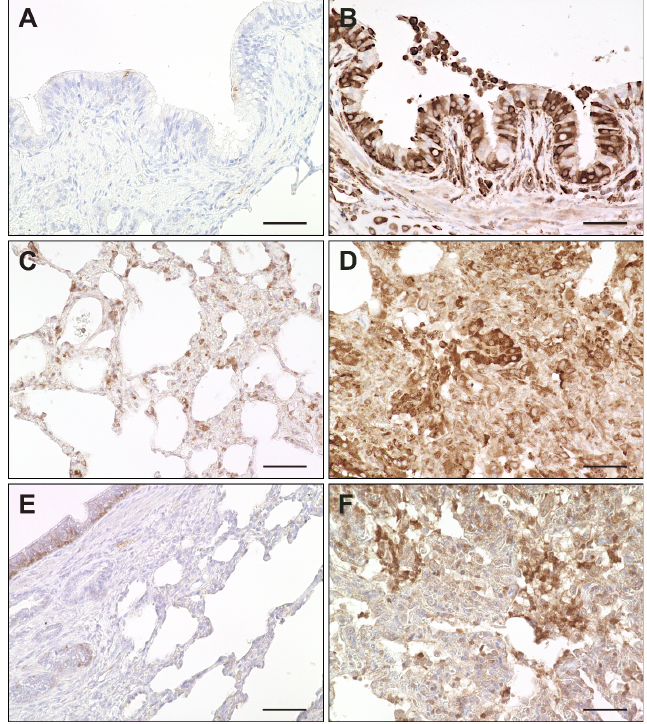
Figure 11. Expression of interferon ‐ related genes in canine distemper virus (CDV) ‐ infected lungs. ( A , B ) Mx protein in a non ‐ infected ( A ) and acutely CDV ‐ infected lung ( B ). ( C , D ) Protein kinase R (PKR) antigen detection in a non ‐ infected ( C ) and acutely CDV ‐ infected lung ( D ). ( E , F ) Interferon ‐ simulated gene 15 (ISG15) antigen detection in basal bronchial epithelium of a non ‐ infected lung ( E ) and in an acutely CDV ‐ infected lung ( F ). Scale bars: 50 μ m.